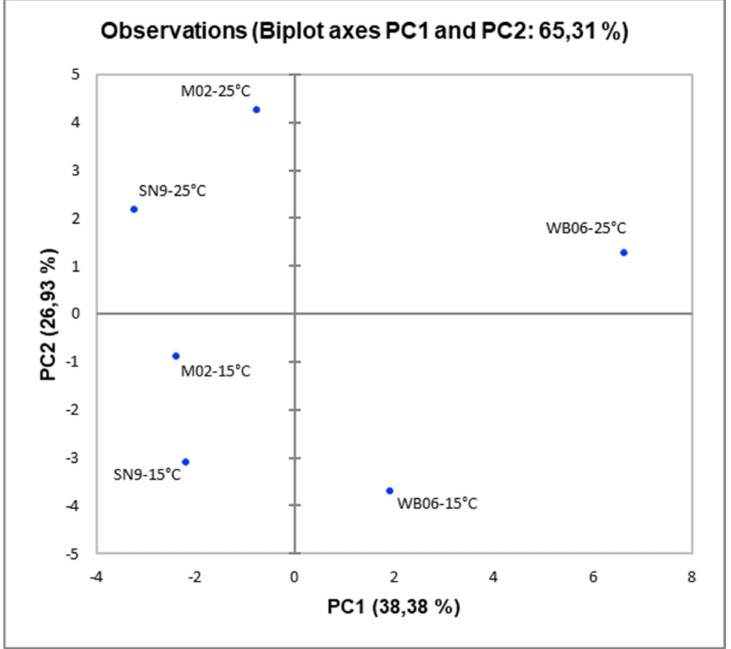
Figure 2. Principal component analysis (PCA) plot of minor volatiles isolated by pomegranate alcoholic beverages fermented at 15 ◦ C and 25 ◦ C by di ff erent yeasts (M02, SN9,